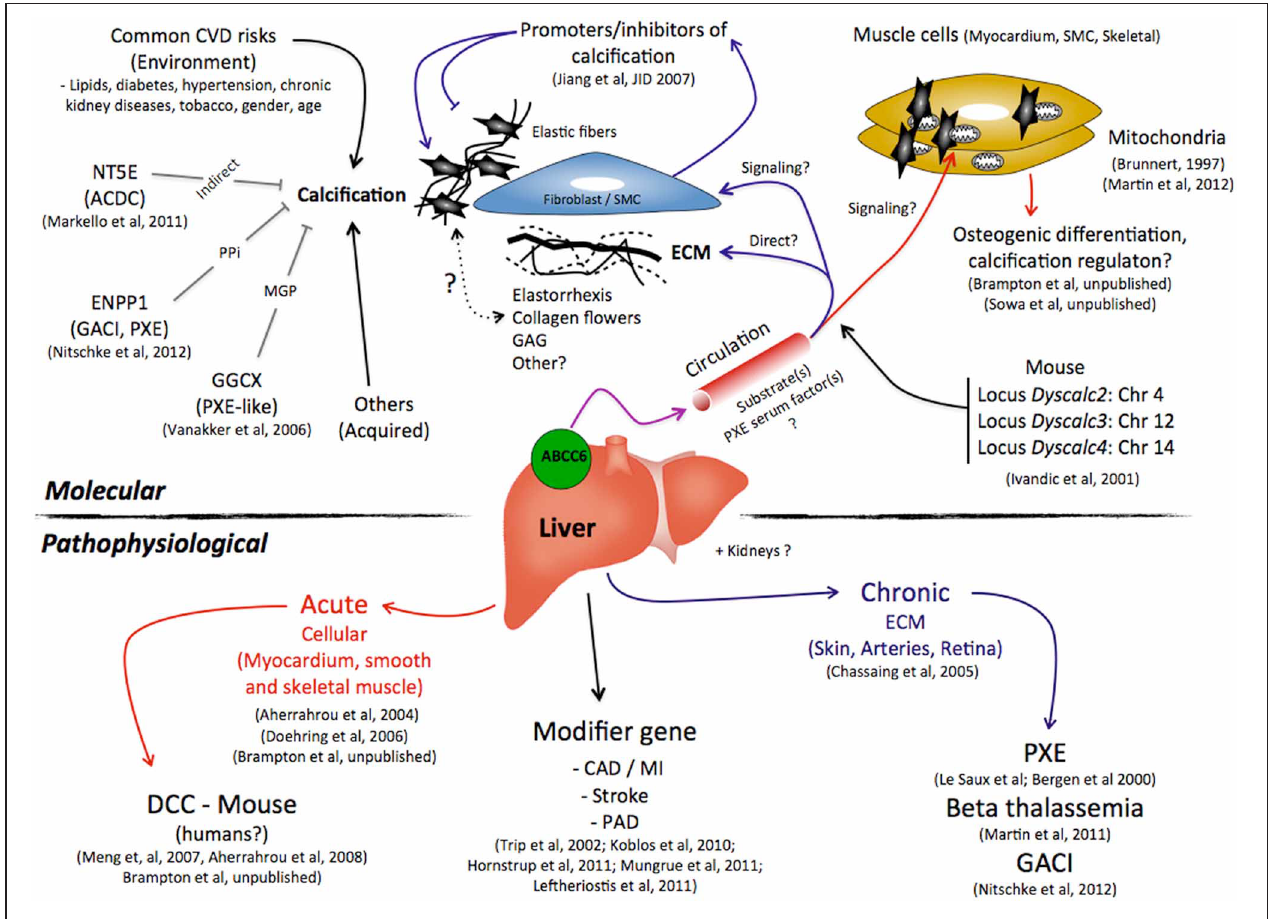
FIGURE 1 | A summary of the possible molecular and pathophysiological roles that ABCC6 plays in the ectopic calcification as seen in pseudoxanthoma elasticum, β -thalassemia, generalized arterial calcification of infancy, dystrophic cardiac calcification, and